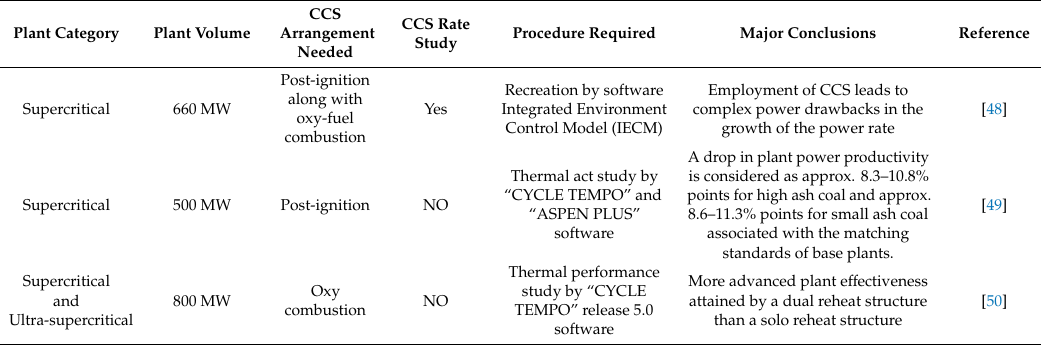
Table 9. CO 2 Capture and Storage-related work around